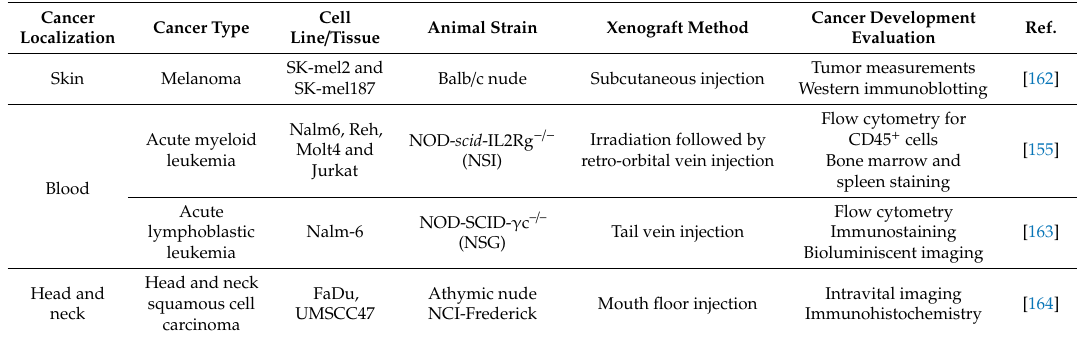
Table 4. Selected in vivo cancer inoculation